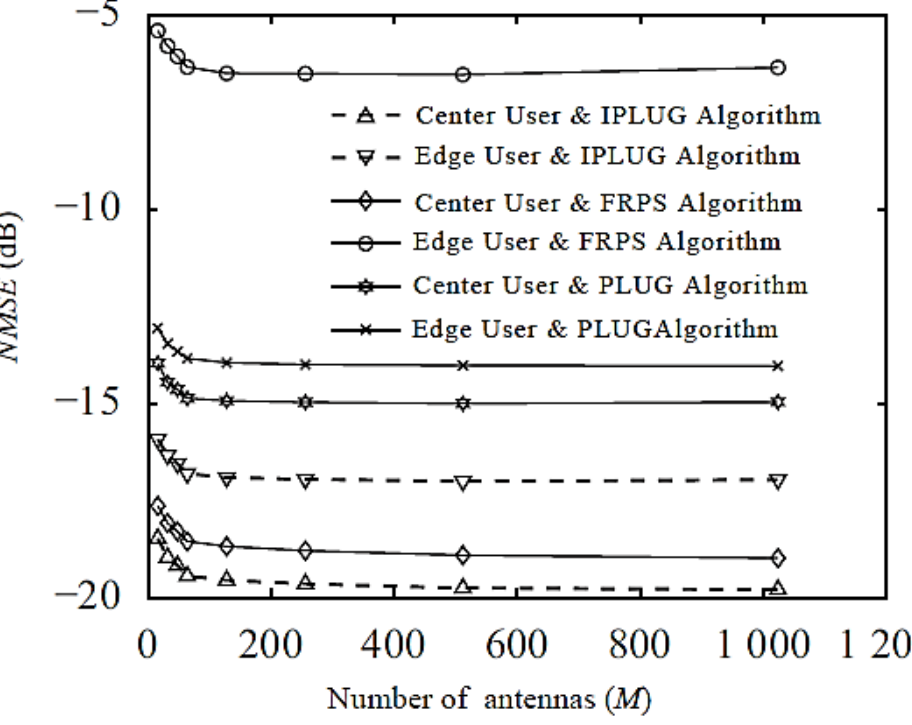
Figure 13. NMSE comparison of IPLUG, FRPS, and PLUG algorithms. Figure 11. NMSE comparison of IPLUG, FRPS, and PLUG